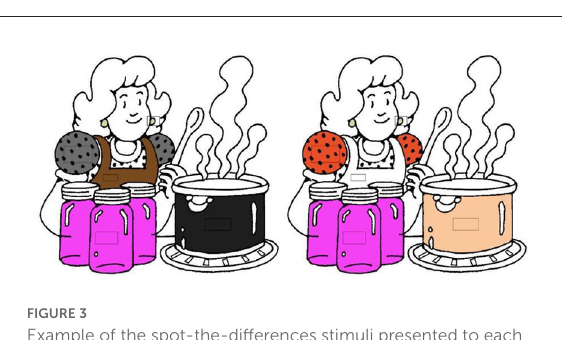
FIGURE3 Example of the spot-the-differences stimuli presented to each